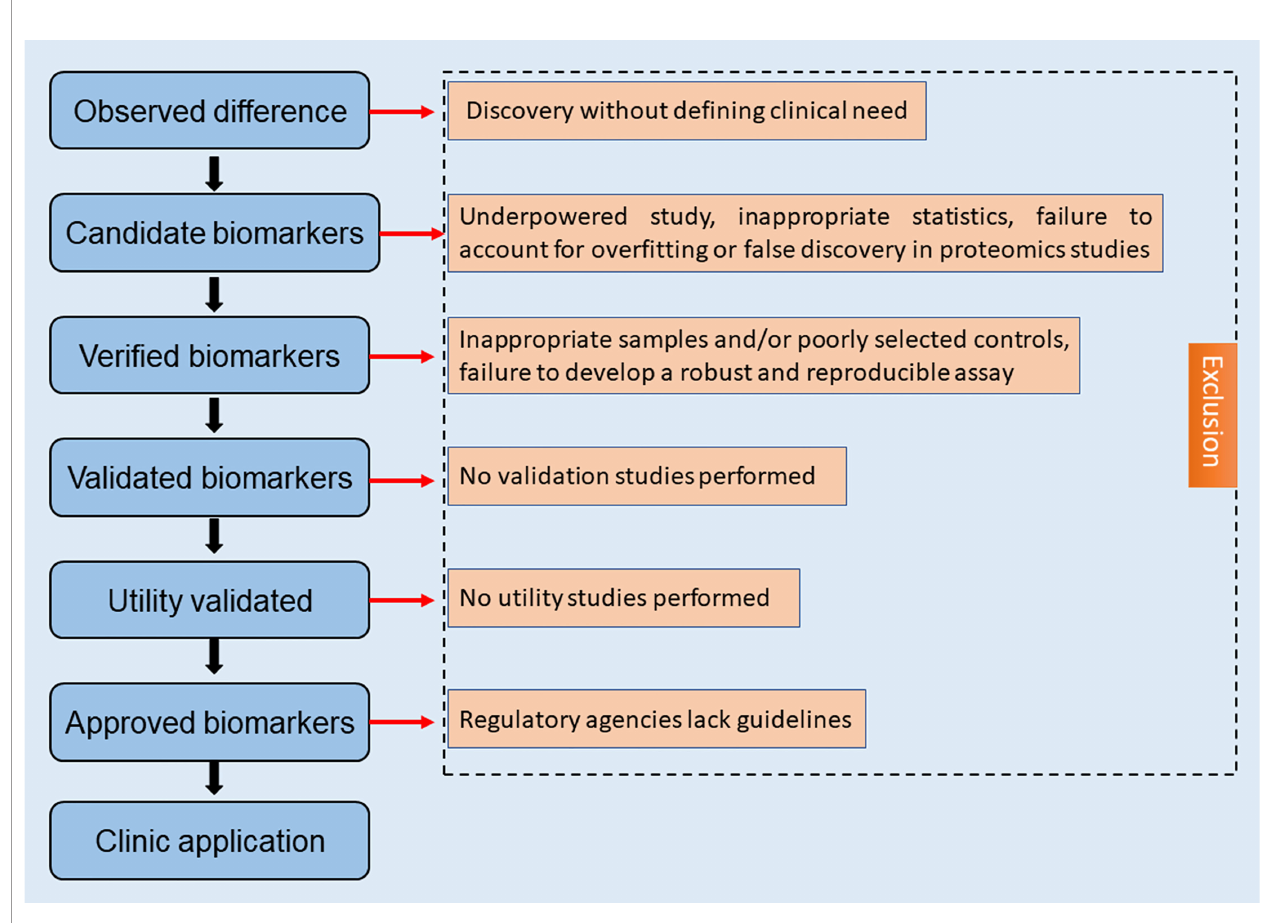
FIGURE 3 | Radiosensitivity biomarkers development from proteomics to